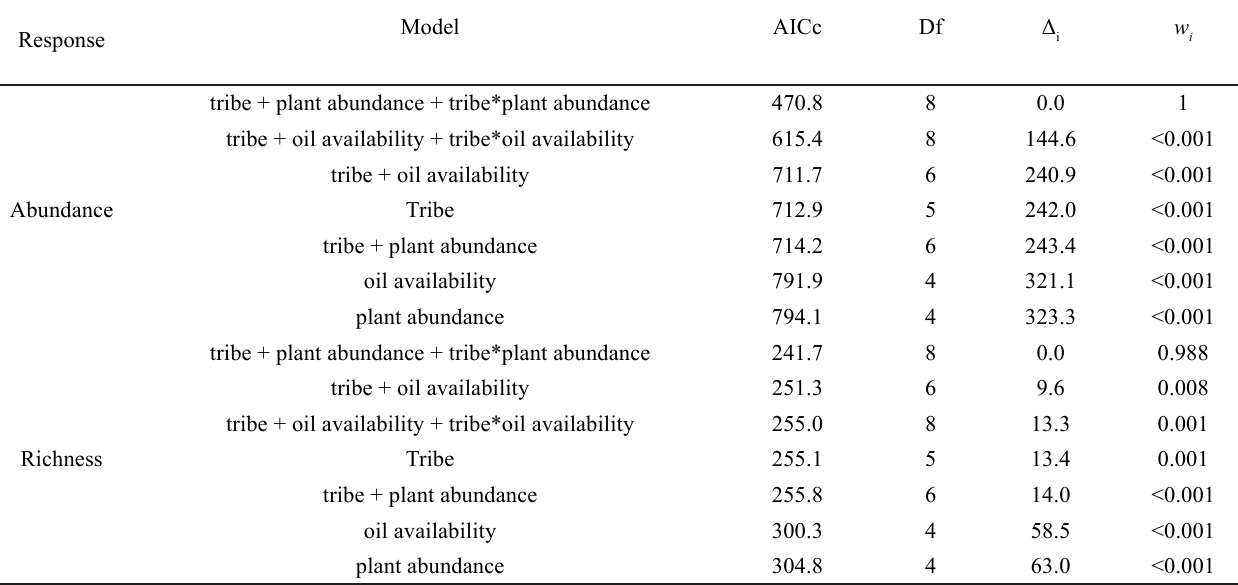
Table 4 . Summary of the models describing variation in total bee abundance and richness in relation to the tribe (Centridini, Tapinotaspidini, and Tetrapediini), plant abundance, and oil availability, in two species of Byrsonima (Malpighiaceae) in a cerrado area in Chapada Diamantina, northeastern Brazil. AICc represents the value of the Akaike Information Criterion corrected for small samples; Δi is the difference between the most parsimonious model i, wi is the Akaike weight of model i. Wi is the probability that the model is the best one among all candidate models.